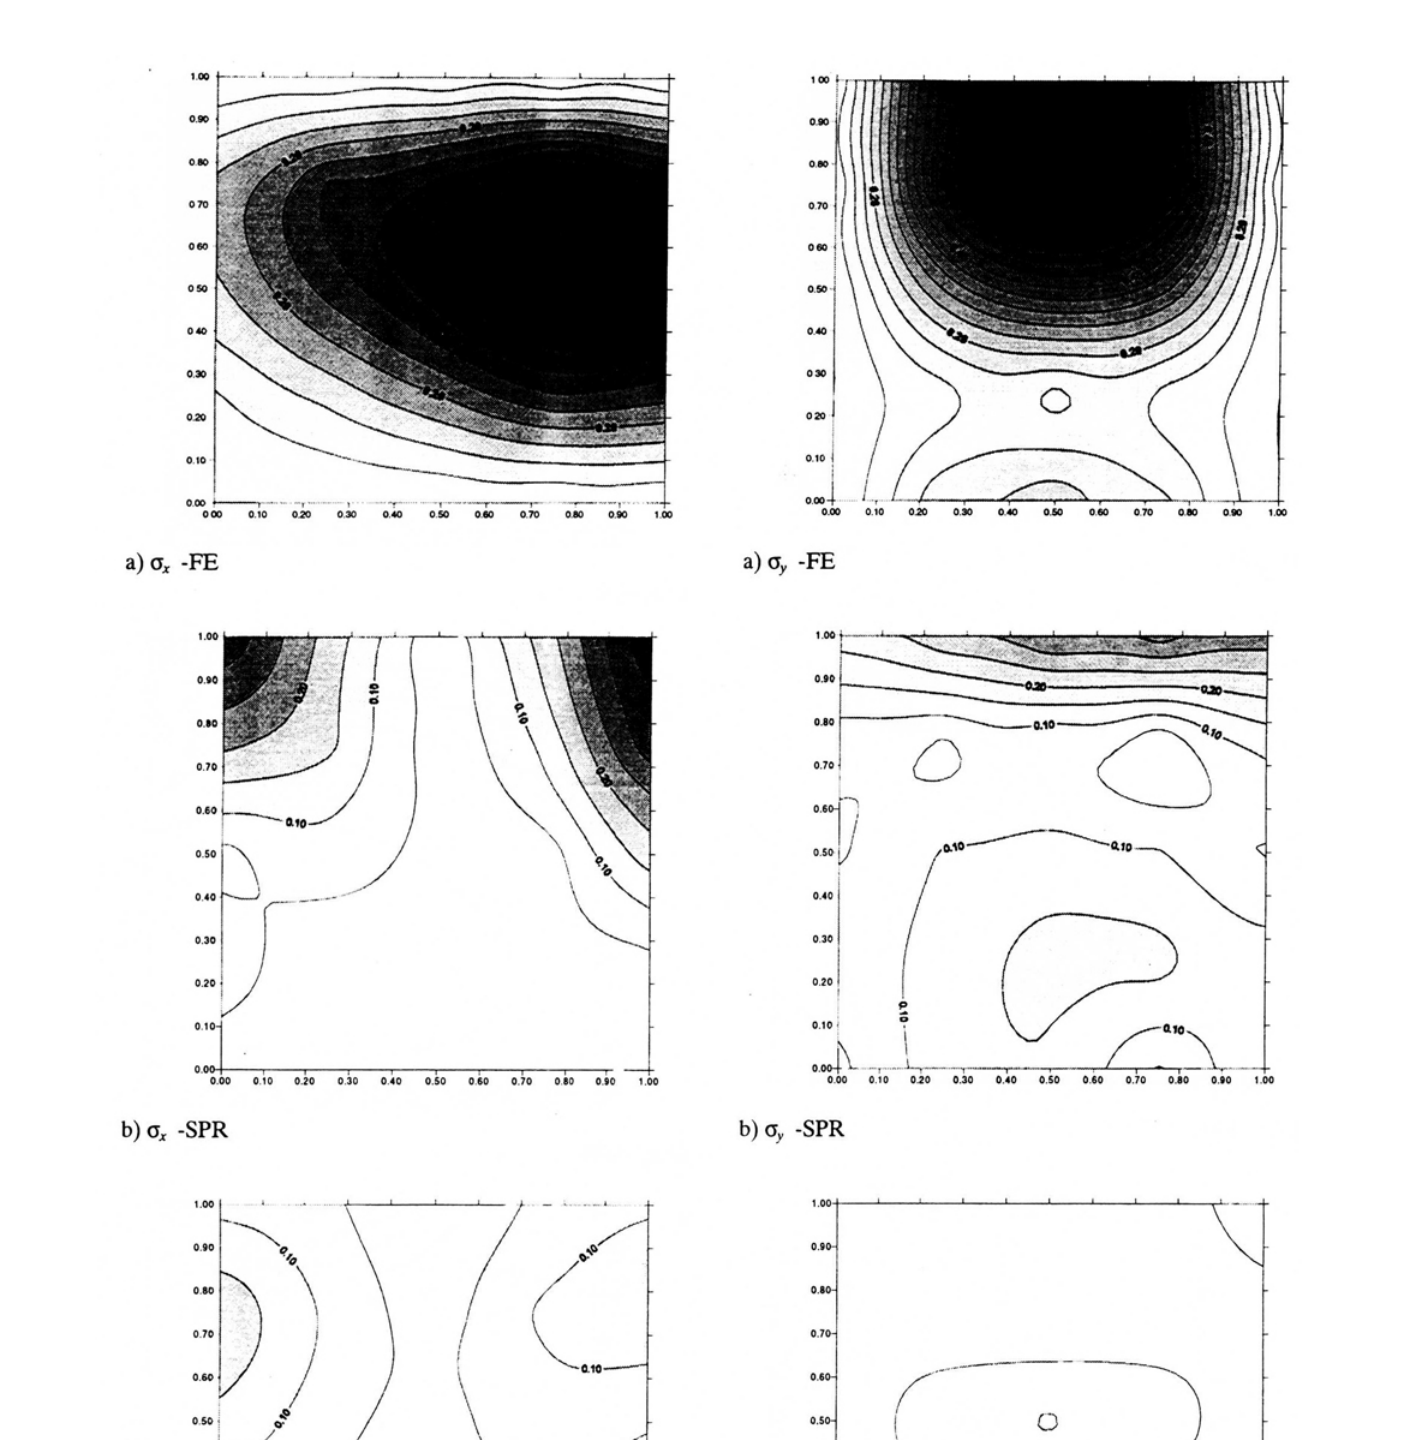
Fig 2. Distribution of absolute error in flux component crx using quadrilateral elements